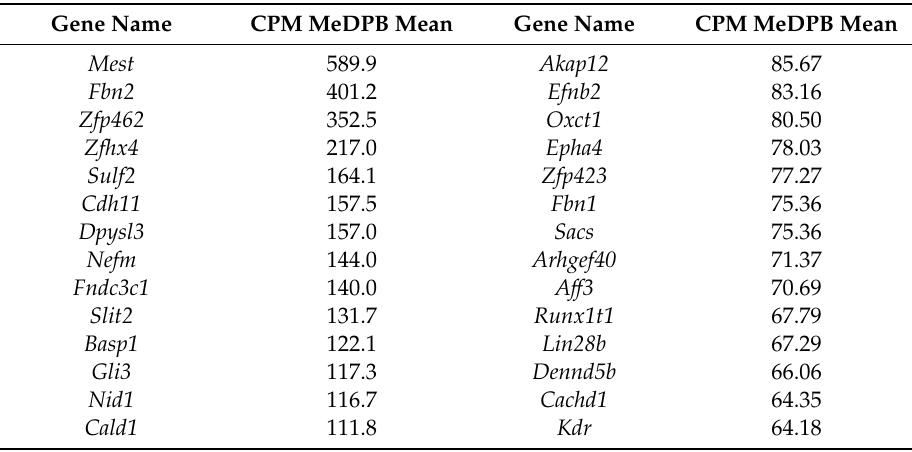
Table 2. List of the enriched MeDPB genes in mouse embryo at